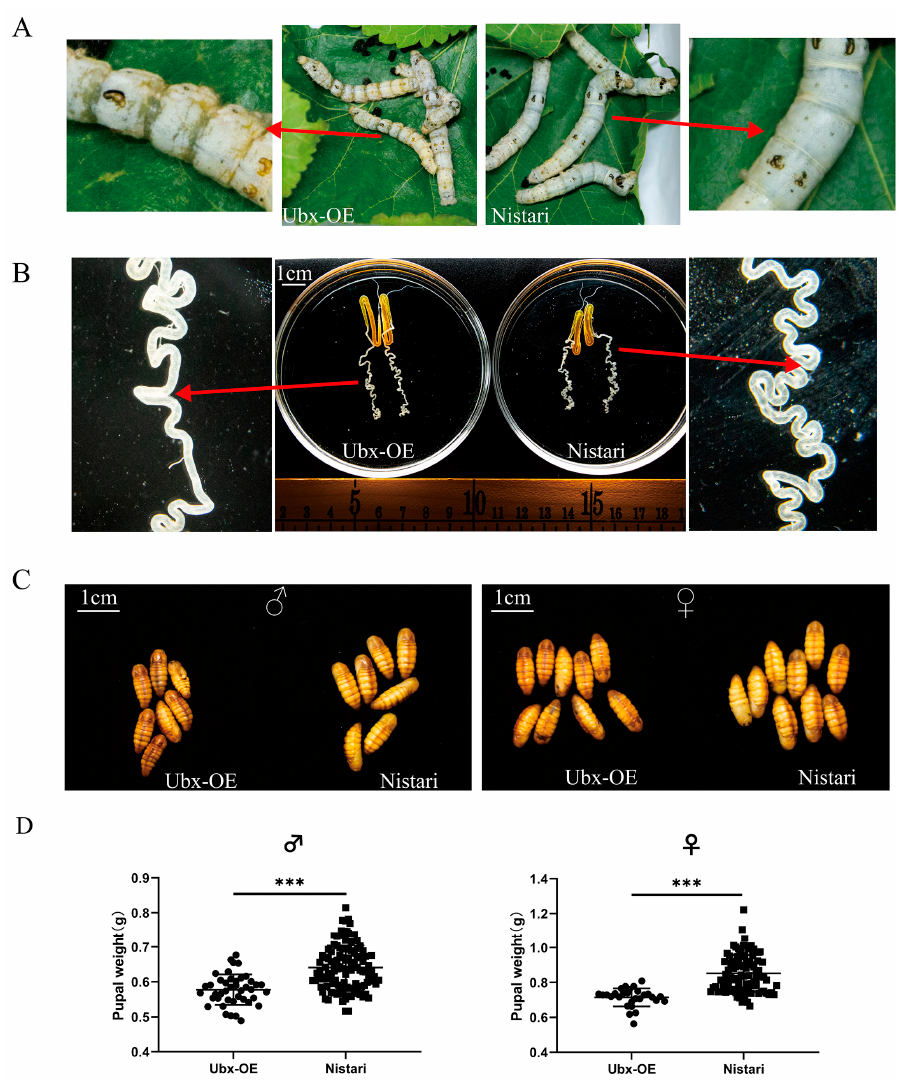
Figure 3. The phenotype changes between Ubx OE and Nistari. ( A ) Intersegmental membrane of fifth-instar larva of Ubx OE and Nistari. ( B ) The posterior silk gland on fourth day of fifth instar (5L5D) of Ubx OE and Nistari. ( C ) The male and female pupae of Ubx OE and Nistari. ( D ) The male and female pupal weight of Ubx OE and Nistari. The scale in bar the upper left of pictures shows 1 mm. Ubx-OE, the transgenic strain with Ultrabithorax overexpressed, namely Ubx OE . Nistari, the control of Ubx OE . Statistical samples > 30. Significant differences were assessed using Student’s t -test (*** p < 0.001).